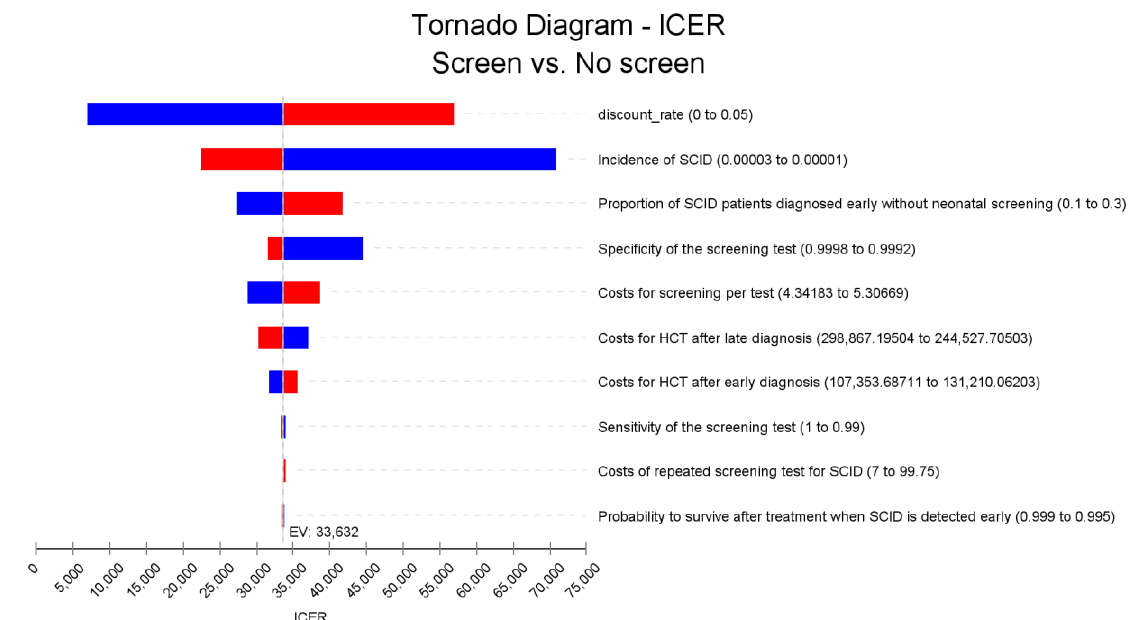
Figure 4. Cost-effectiveness plane for SCID NBS vs. no NBS, government perspective over 60 years, discounted US$ (d = 3% p.a.). (Note: Green dots represent iterations considered cost-effective (ICER less than the willingness-to-pay (WTP) threshold US$35,000/QALY); while red dots represent itera- tions considered not to be cost-effective (ICER greater than the WTP threshold).